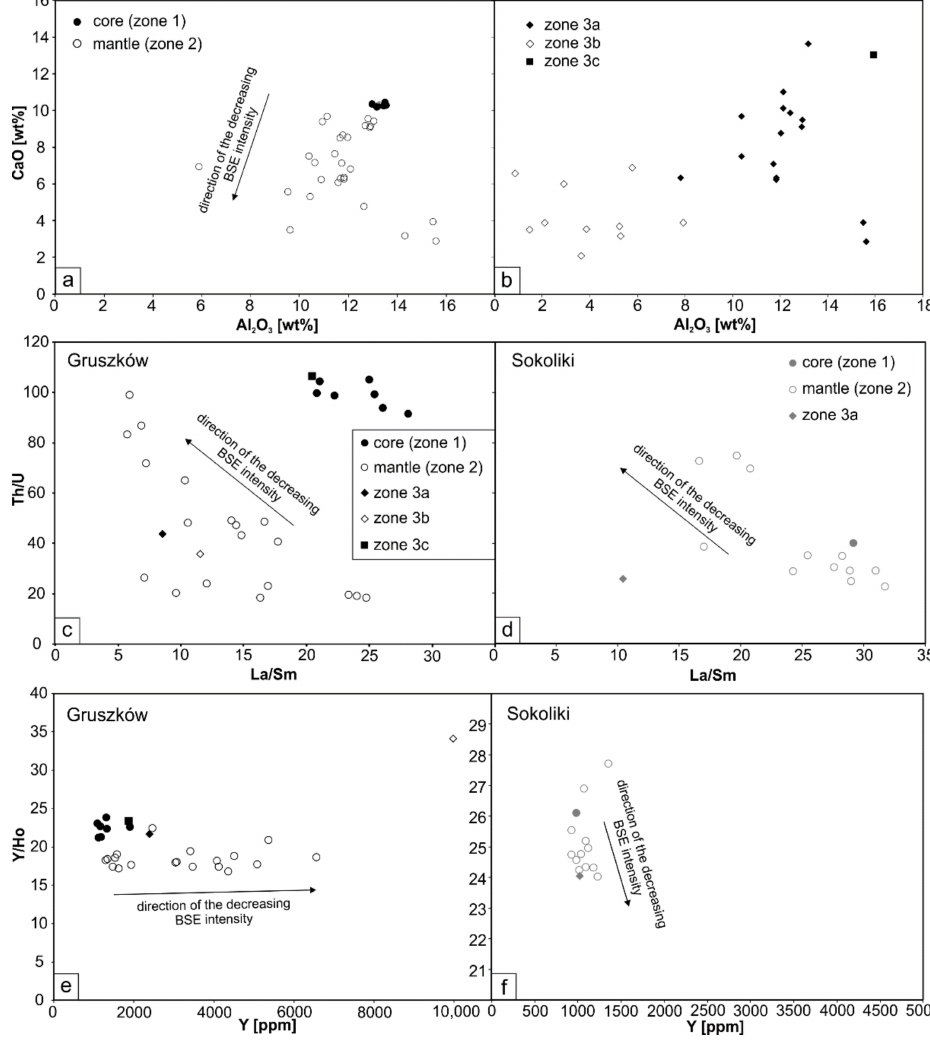
Figure 3. Variation diagrams illustrating the compositional di ff erences between the distinguished textural groups; ( a , b ) Al 2 O 3 vs. CaO [wt %], ( c , d ) La / Sm vs. Th / U [ppm], and ( e , f ) Y [ppm] vs. Y / Ho. Gruszk ó w and Sokoliki samples are presented together in ( a ) and ( b ) , as di ff erences in major element contents are insignificant. The arrows in plots ( a , c ) and ( e ) show the evolution of element concentrations as BSE-intensity